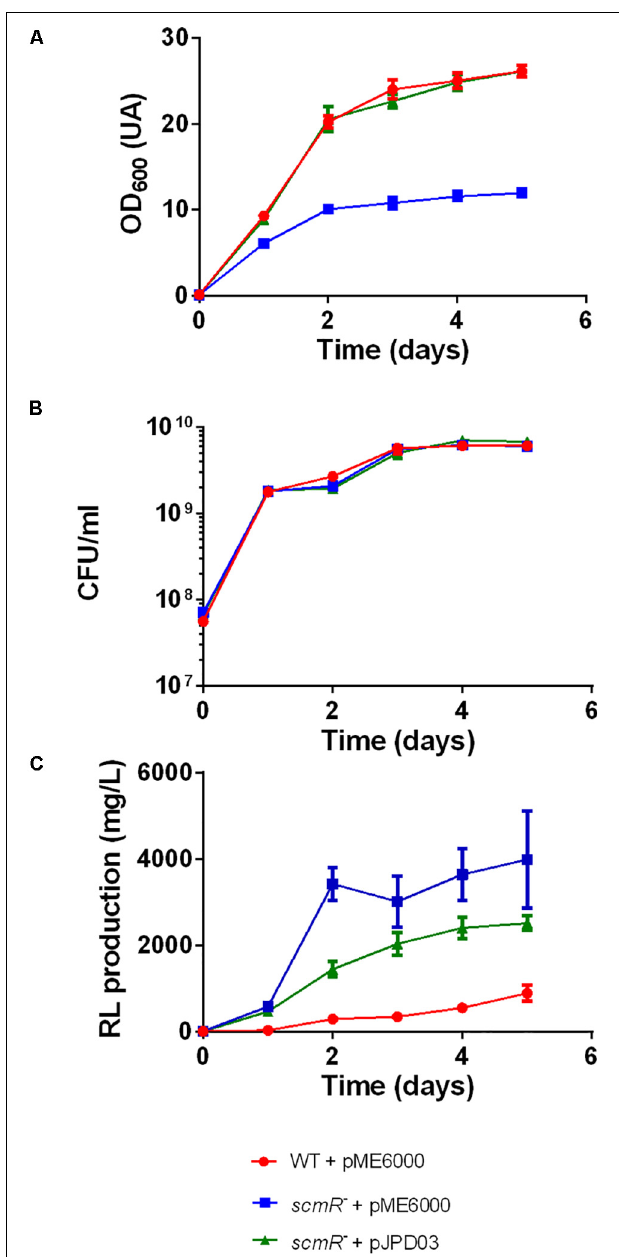
FIGURE 2 | A scmR mutant produces more rhamnolipid than the WT strain. (A) Growth (OD 600 ), (B) Growth (CFU/mL), and (C) rhamnolipid production (mg/L). The values are means ± standard deviation (error bars) for three replicates.